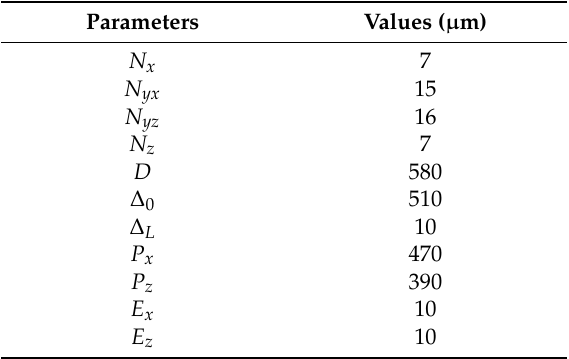
Table 2. Parameter values used in simulation by the finite element